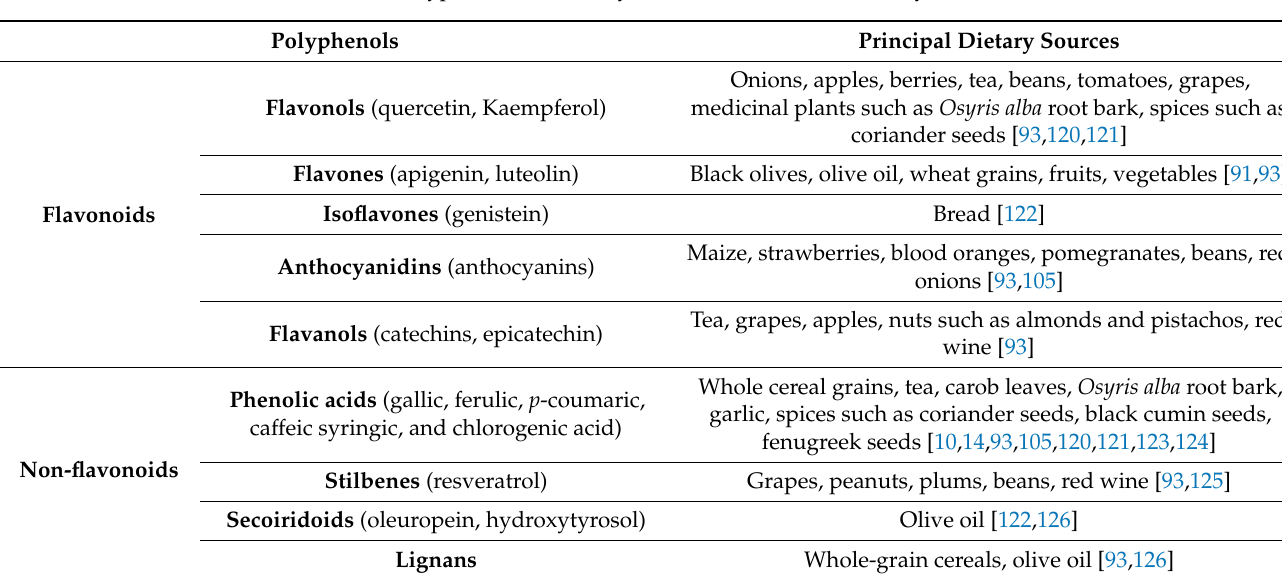
Figure 2. Chemical structure of some dietary polyphenols. Table 1. Polyphenols commonly found in a Mediterranean ‐ style diet.